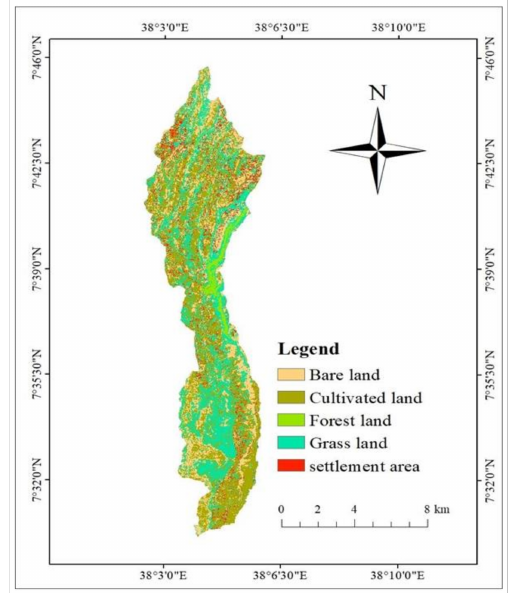
Figure 7. The LULC Map of Matenchose watershed in